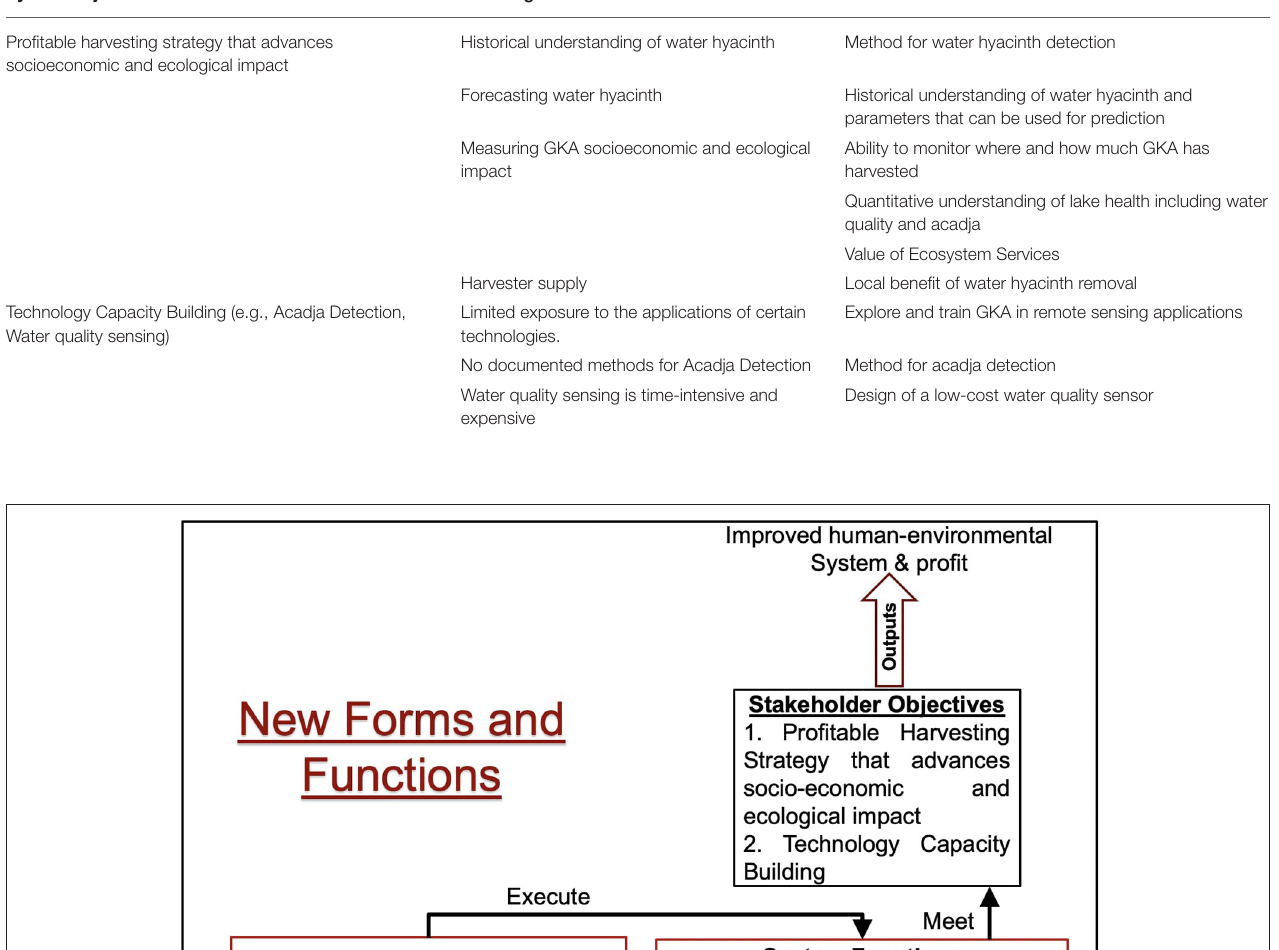
TABLE 4 | Summary of challenges related to stakeholder system objectives and proposed forms that could address these challenges. System objectives